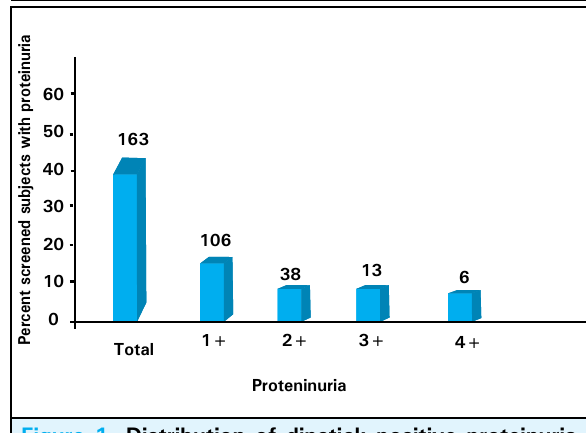
Figure 1. Distribution of dipstick positive proteinuria in the screened population (n=3218 subjects).